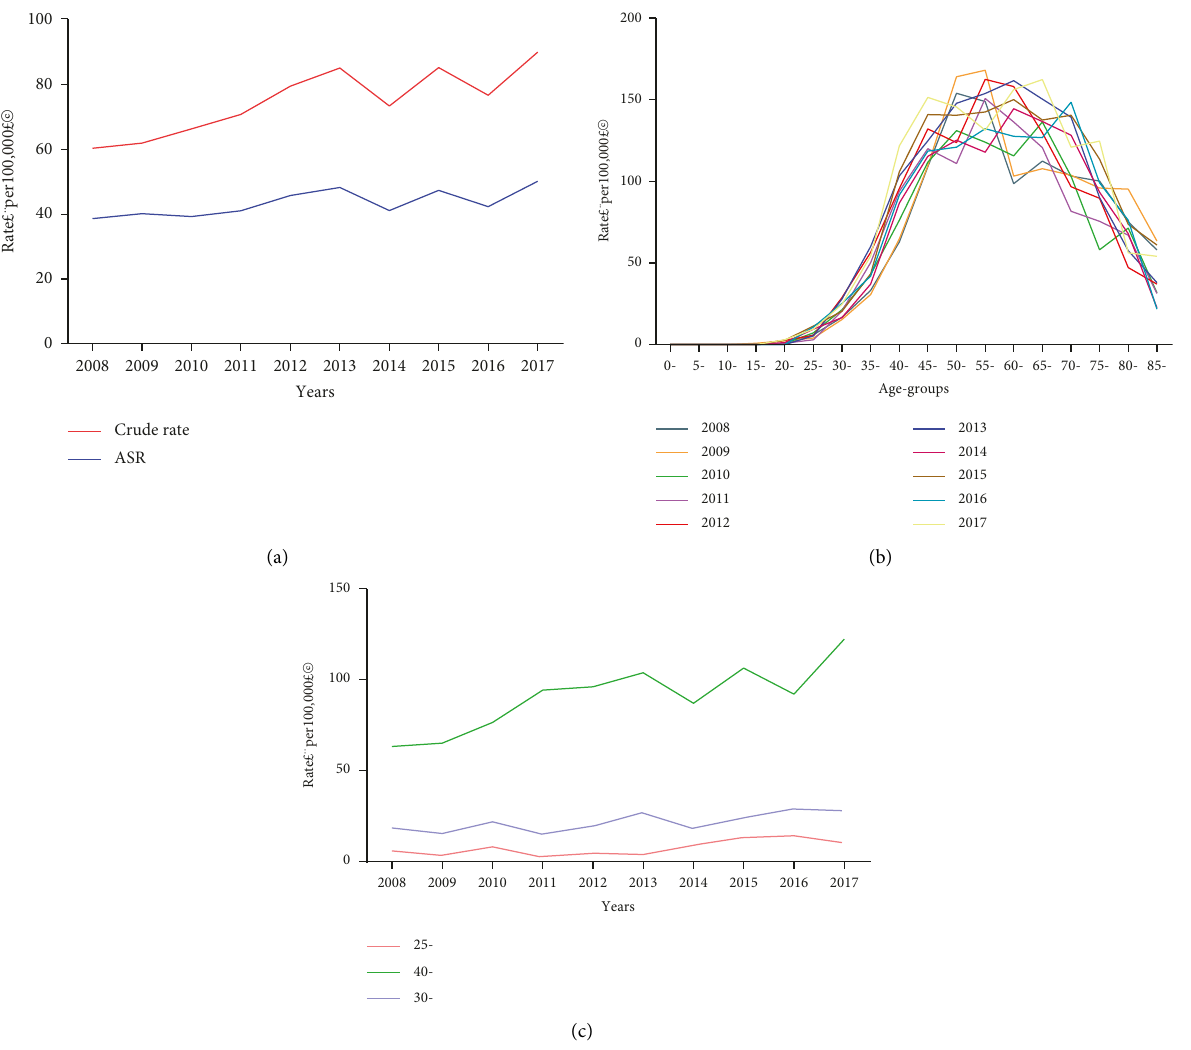
Figure 1: Incidence of female breast cancer in urban Shenyang in 2008–2017. (a) Overall incidence. (b) Age-specific incidence rates. (c) Age- specific incidence trends of female breast cancer for three age groups over time. The 25–29 years, 40–44 years, and the 30–34 years age groups showed the most increase in incidence over time. ASR, age-standardized incidence